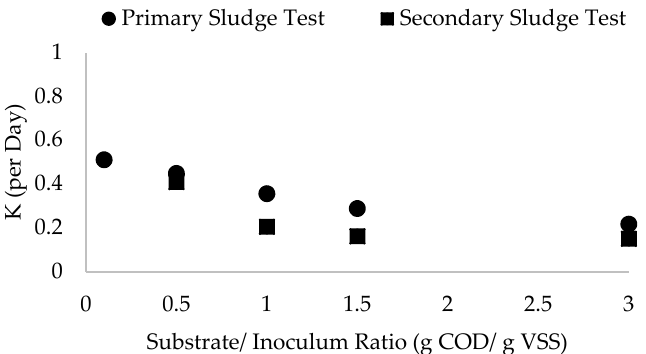
Figure 7. Relationship between methane production rate constant and substrate/inoculum ratio.